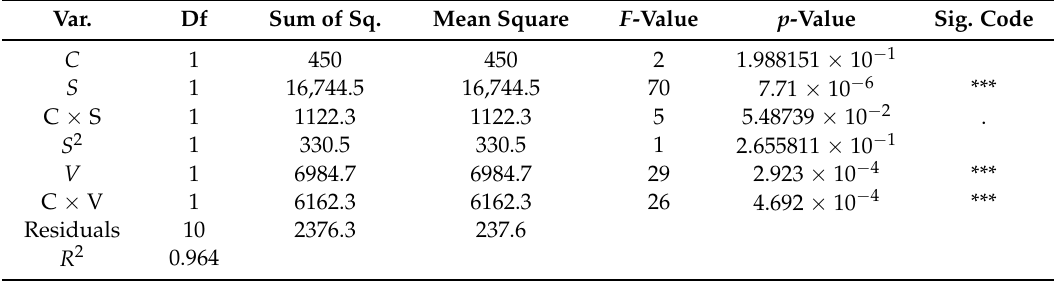
Table 5. ANOVA table for the “ H ” quadratic model.